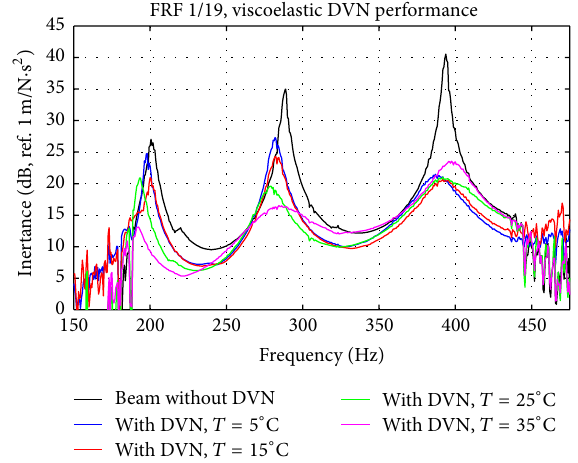
Figure 11: Passive vibration control system (viscoelastic DVN) performance.